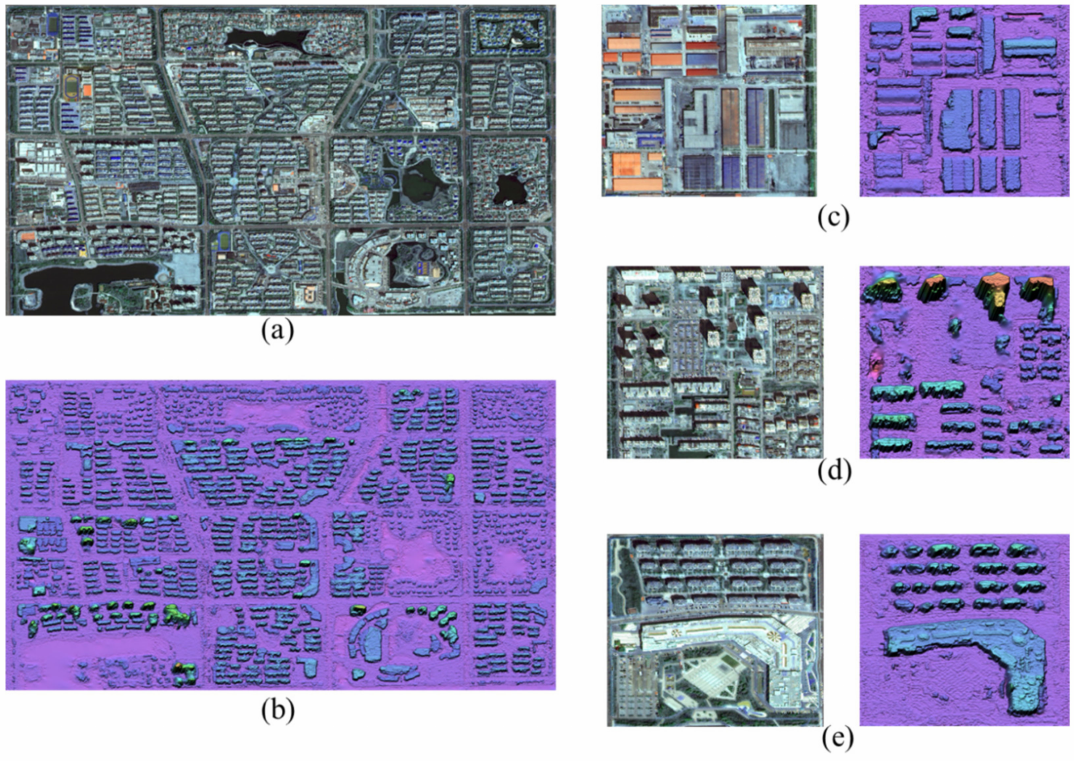
Figure 12. Effect of GF-7 DSM. ( a ) Clip of fused multispectral image; ( b ) clip of DSM; ( c – e ) clips of views from different types of